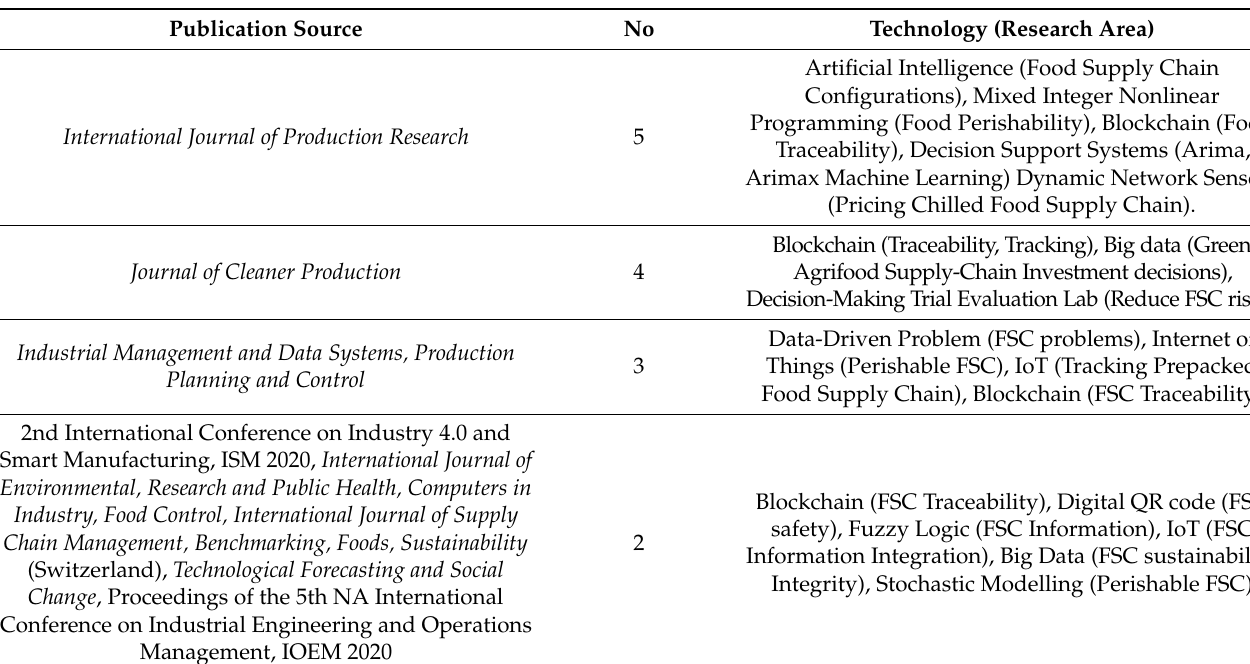
Figure 3. Trend in Publication. Table 1. Source of Publications vs. Technology (Targeted Research